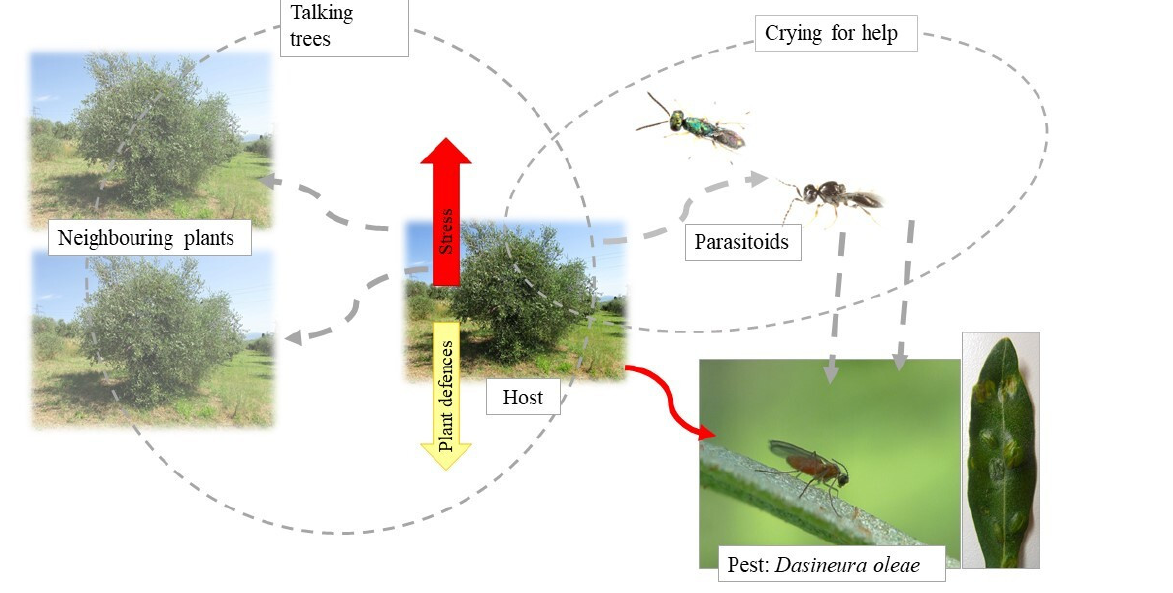
Figure 2. The tritrophic interaction of Dasienura oleae (Diptera: Cecidomyiidae), its parasitoids and the olive tree could be hypothetically altered by global heating. Under increasing temperature (atmosphere and soil), the olive tree starts suffering, and the production of secondary metabolites and other plant defensive traits (e.g., the phenomena of “talking tree” (host–host) and “crying for help” (host–parasitoids)) may be affected [2]. This may cause a disequilibrium of the tritrophic interaction and the consequent occurrence of pest outbreaks [2,100].